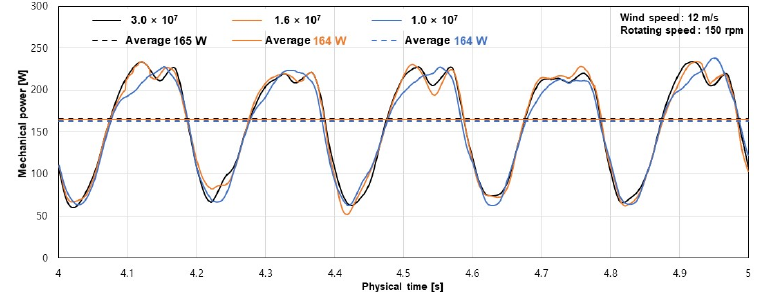
Figure 2. Rotor power according to number of grid cells.